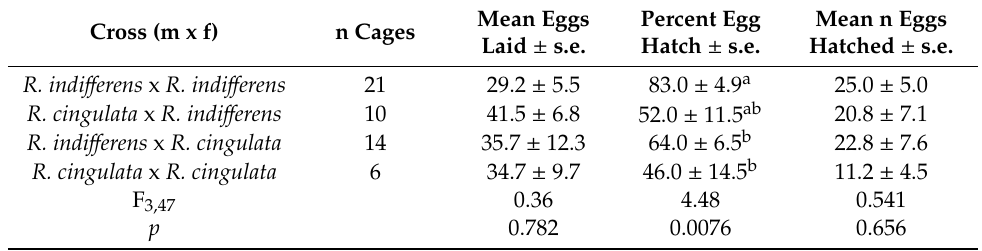
Figure 4. Mitochondrial DNA (mtDNA) maximum parsimony gene tree (51 steps) built from 609 total bp of cytochrome oxidase II (COII), sequenced for R. cingulata species group flies across North America. Values in parentheses indicate the number of identical haplotypes sequenced from di ff erent individuals within a population, with site number designated inside the nodes, as given in Table 1 and Figure 1. Also shown along the branches are the number of base pair substitutions, with the bootstrap support levels for nodes (based on 10,000 replicates) in brackets. The tree is rooted with the outgroup walnut husk-infesting fly, R. suavis , from East Lansing, Michigan. Table 3. Mean number of eggs laid per cage, mean percentage of eggs hatched per cage, and mean number of eggs hatched per cage for parental and reciprocal crosses between R. cingulata from the Eastern USA and R. indi ff erens from the Pacific Northwest. Letters denote significantly di ff erent means, according to Tukey